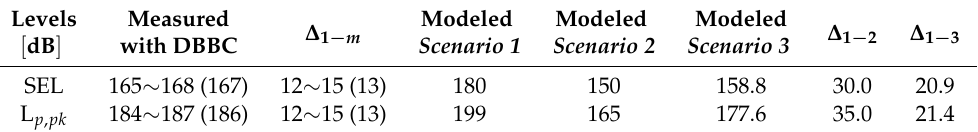
Figure 10. The energy flux at the location of the outer bubble curtain r = r bc ,2 = 145 m over the fluid and soil domain. Table 3. The summary of predicted noise reduction levels and experiment data from the pile installation campaign.